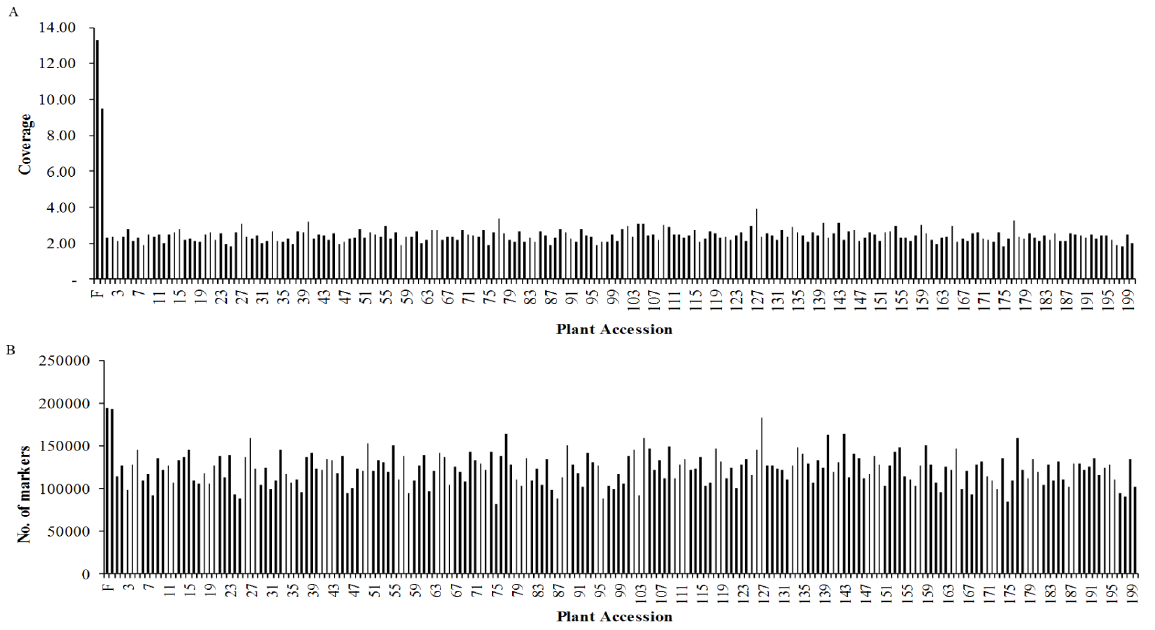
Fig 1. Coverage and number of markers for each of F 1 progeny individual and two parents. The x -axes in both A and B indicate the plant accession including the female parent and the male parent followed by 195 F 1 progeny individuals, the y-axes indicates coverage in A and number of markers in B .